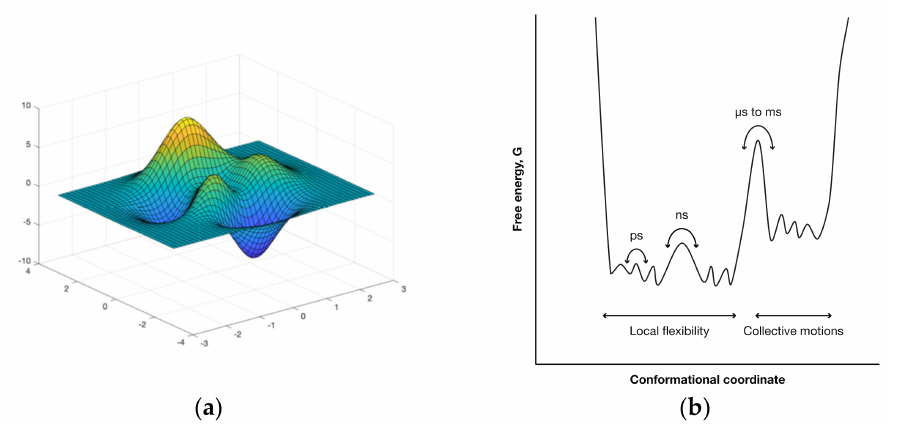
Figure A5. Representation of potential energy surface. A deep minimum in the potential energy surface indicates a stable structure (Panel a ). One-dimensional cross-section through the multi- dimensional energy landscape of a protein. A conformational state is defined as a minimum in the energy surface. The difference in the Gibbs free energy between two states determines the rate of interconversion. Any change in the system, such as ligand binding, external conditions or mutation, will shift the equilibrium between states (Panel b ).